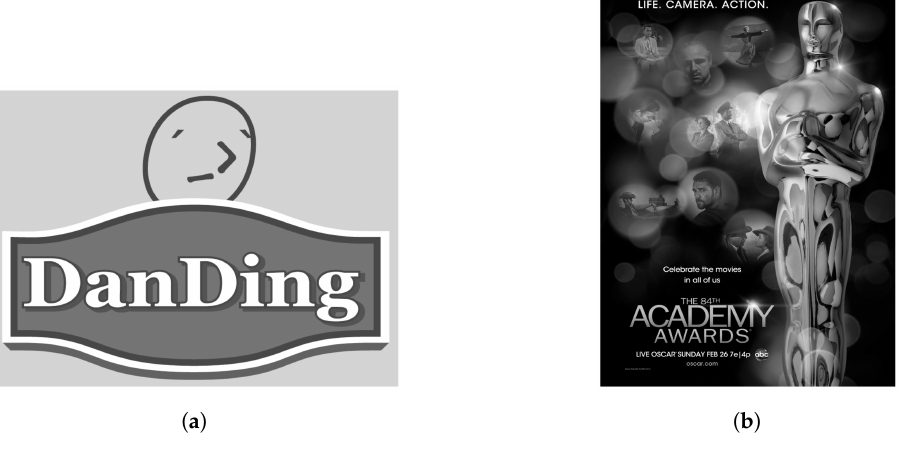
Figure 25. Test images, Part 2. ( a ) logo, 1024 × 768; ( b ) Poster [30], 840 × 1224.